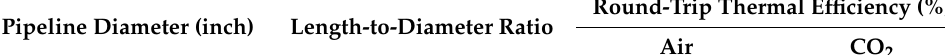
Table 4. Pipeline diameter and the different length-to-diameter ratios along with the round-trip thermal efficiency for air and CO 2 .